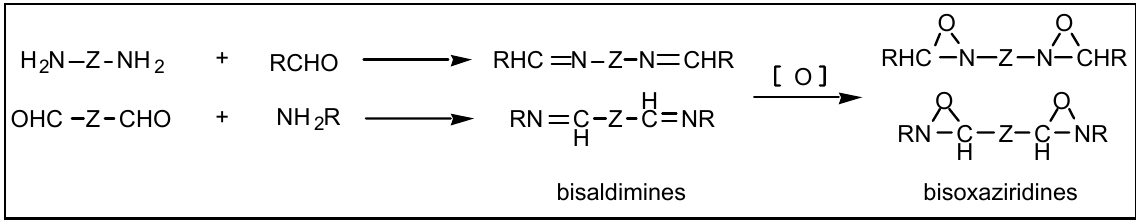
Scheme 1 . Bisaldimine precursors and target